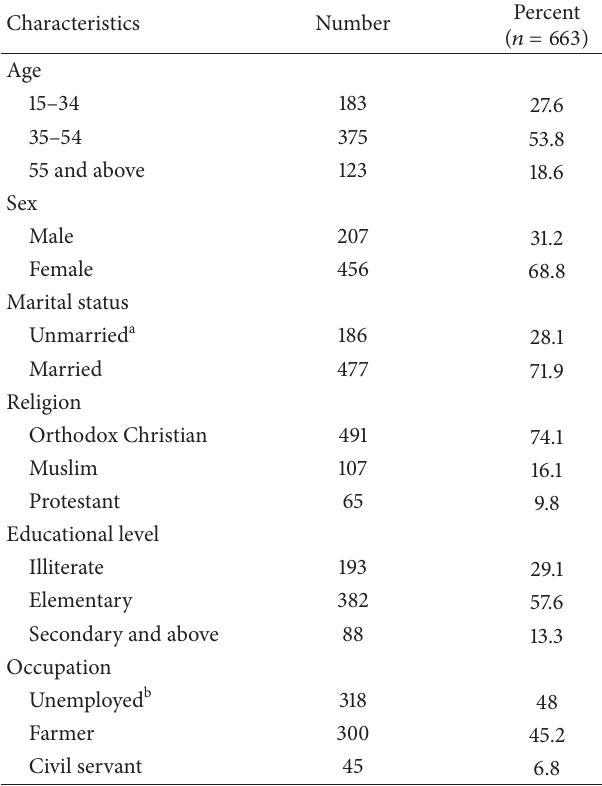
Table 1: Sociodemographic characteristics of pulmonary tubercu- losis suspects in Lay Armachiho district, Northwest Ethiopia, 2014.